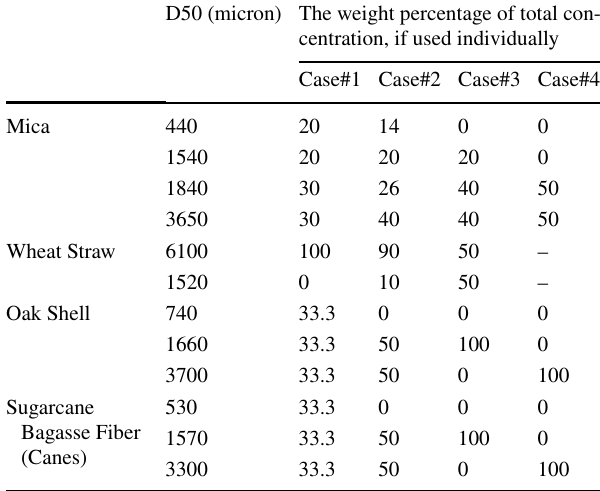
Fig. 3 Herschel-Bulkley model for bentonite mud